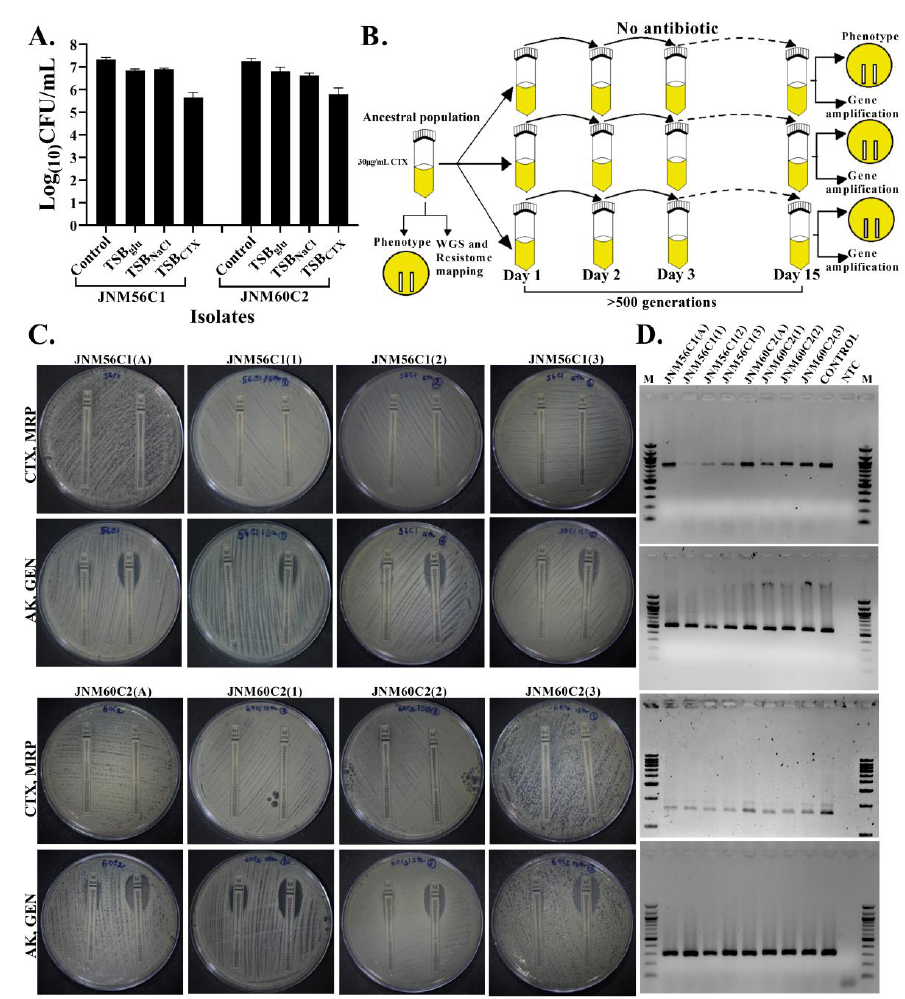
Figure 3. No change in in vitro antibiotic susceptibility among MDR, biofilm-forming S. haemolyticus isolates (JNM56C1 and JNM60C2) grown in the absence of antibiotics in short-term evolution experiments. ( A ). The presence of living sessile cells is confirmed by log (10) CFU counts in both isolates in the presence of 30 μg/mL CTX. The error bars represent standard deviation across three technical replicates. ( B ). Study design of the evolution experiment. ( C ). Comparison of susceptibility to ß-lactam and aminoglycoside antibiotics among ancestral and evolved populations using E-tests. ( D ). The blaZ (858 bp, panel 1), mecA (533 bp, panel 2) and AAC(6 (cid:48) )-APH(2 (cid:48) ) (1658 bp, panel 3) and 16S (292 bp, panel 4) genes were amplified from the ancestral and evolved populations and amplicons were run on 0.8–1.5% agarose gels. M; 100/1000 bp marker, control; positive control, NTC; no template